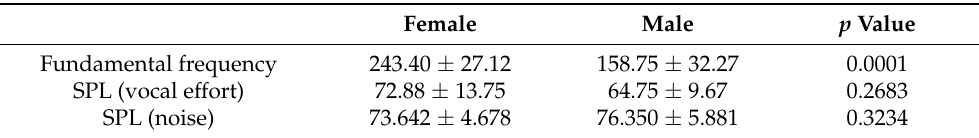
Table 7. Gender differences in fundamental frequency, vocal effort (SPL), and ambient